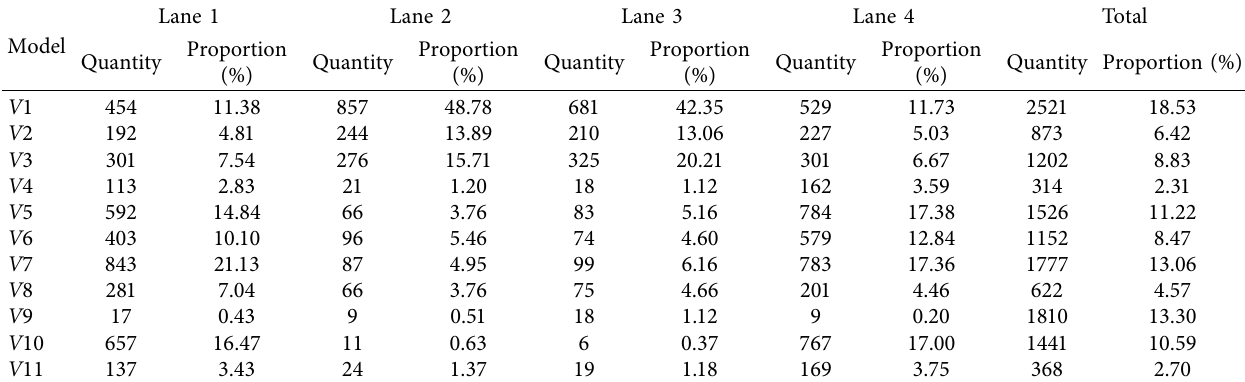
Table 4: Distribution of representative vehicle types on